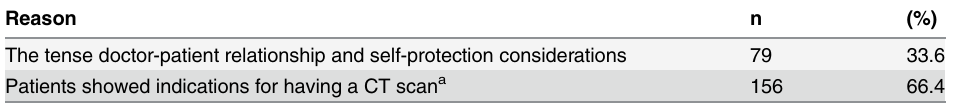
Table 4. The Main Reason for Ordering CT Scans to Investigate Head Injury for Children Reported by Surveyed Clinicians in China. Reason n (%) The tense doctor-patient relationship and self-protection considerations 79 33.6 Patients showed indications for having a CT scan a 156 66.4 a Indications include headache, vomiting, seizure, intoxication, short-term memory de fi cit, suspected skull fracture, serious trauma mechanism,